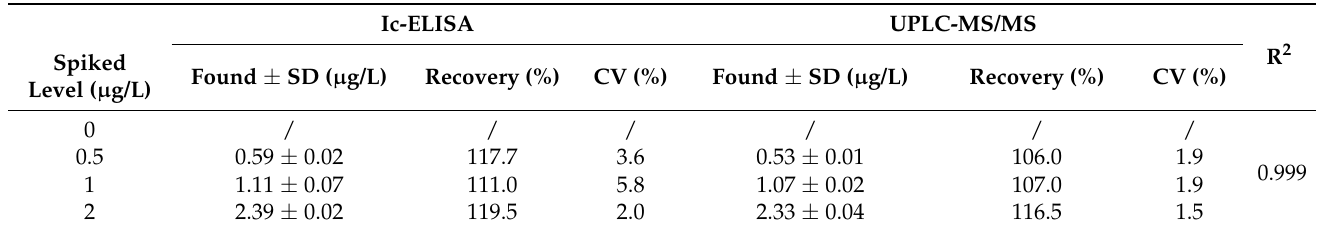
Table 3. Reproducibility and accuracy of NOD-R from spiked water samples by ic-ELISA and LC–MS/MS ( n = 3).